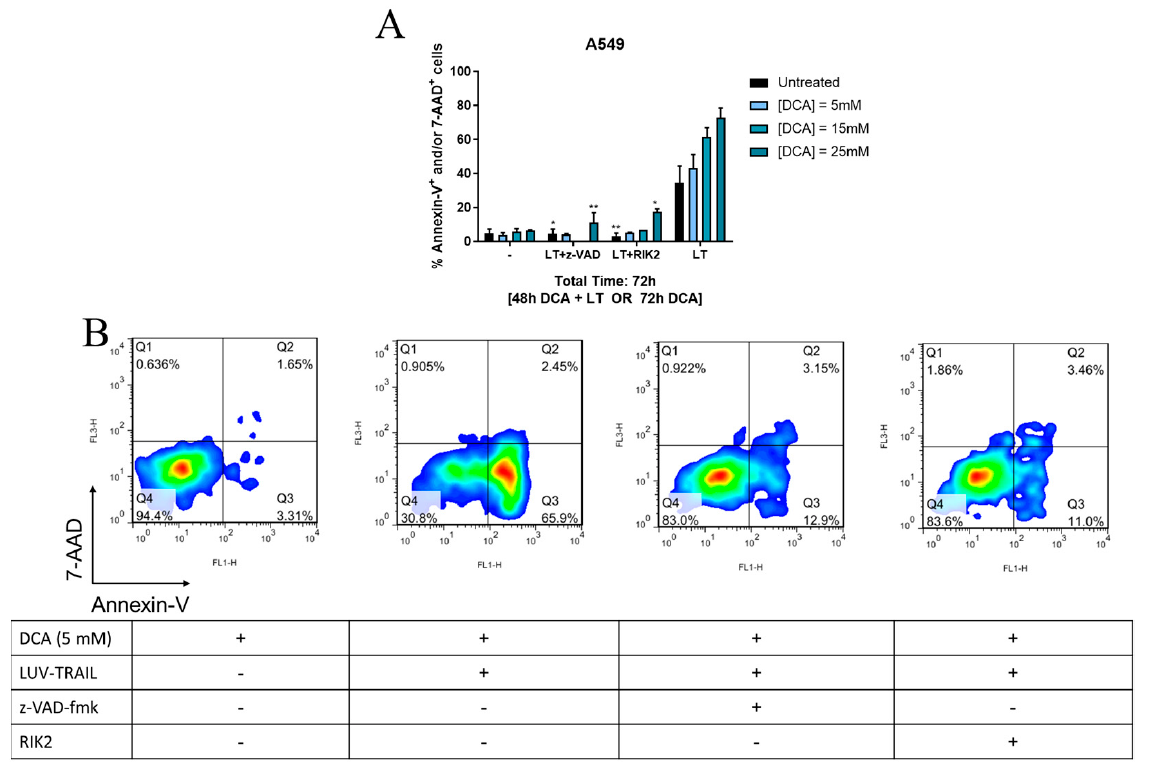
Figure 3. Effect of pan-caspase inhibitor z-VAD and the mAb RIK2 in DCA + LUV-TRAIL (LT)- induced cell death in A549 cells. Tumor cells were incubated with DCA (5–25 mM) for 48 h. After- wards, LT (1000 ng/mL) was added for another 24 h. z-VAD (30 µM) or RIK2 (30 µM) were used 1 h prior to LT exposure. Cell death (by annexin-V-FITC and 7-AAD staining and detection by flow cytometry). Results are represented as mean +/ − SD of at least 2 different experiments with duplicate determinations. Significances (*) referred to the experimental point vs the same column in LT alone. * p < 0.05; ** p < 0.01. ( B ) Representative dot plots of Annexin-V-FITC vs. 7-AAD staining in A549 cells, corresponding to experimental points included in ( A ). DCA: dichloroacetate.